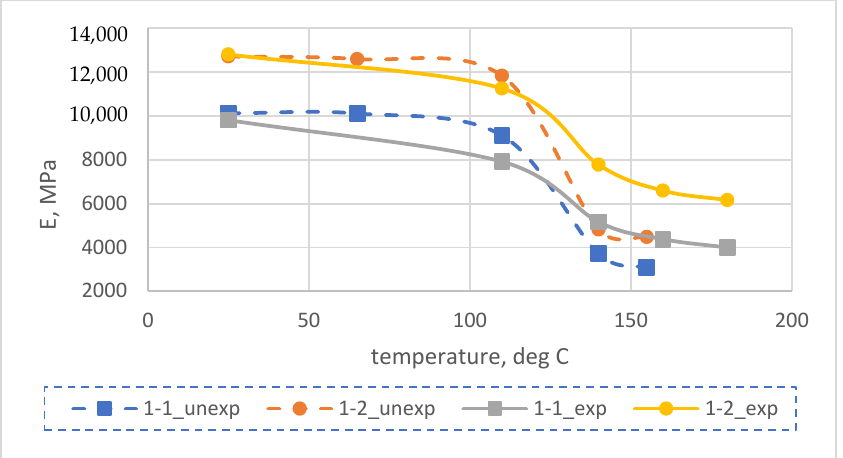
Figure 3. Experimental temperature dependence of elastic modulus (E) at bending of samples No. 1-1, 1-2 of epoxy fiberglass plastic based on EZ-200 glass fabric before (unexp) and after (exp) their exposure to temperatures exceeding the initial glass transition temperature.